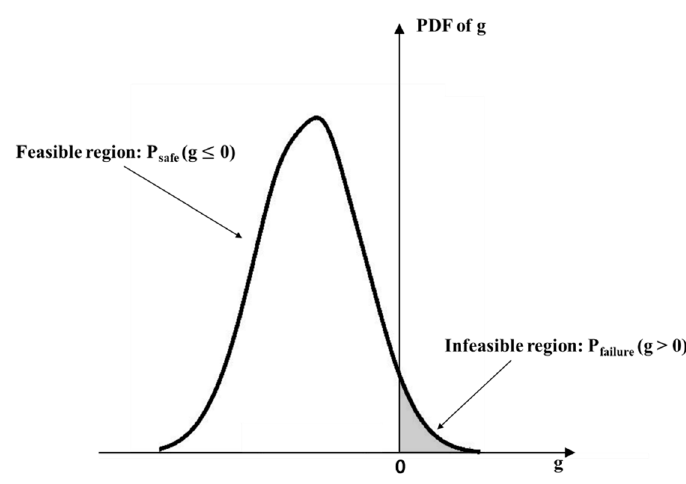
Figure 8. Probability density function of a performance function.